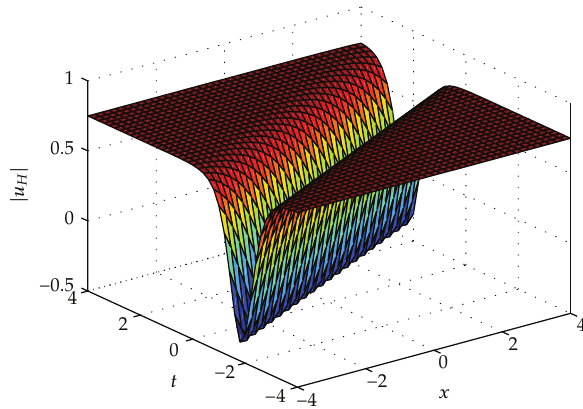
Figure 1: Soliton solution | u H (cid:4) x,t (cid:5) | of the Schr¨odinger-Boussinesq system, (cid:4) 3.12a (cid:5) , for α (cid:3) 1 , β (cid:3) 16 , k (cid:3) 1 , ω (cid:3) − 2, and ρ H (cid:3) tanh − 1 (cid:4) 1 / 4 (cid:5) .